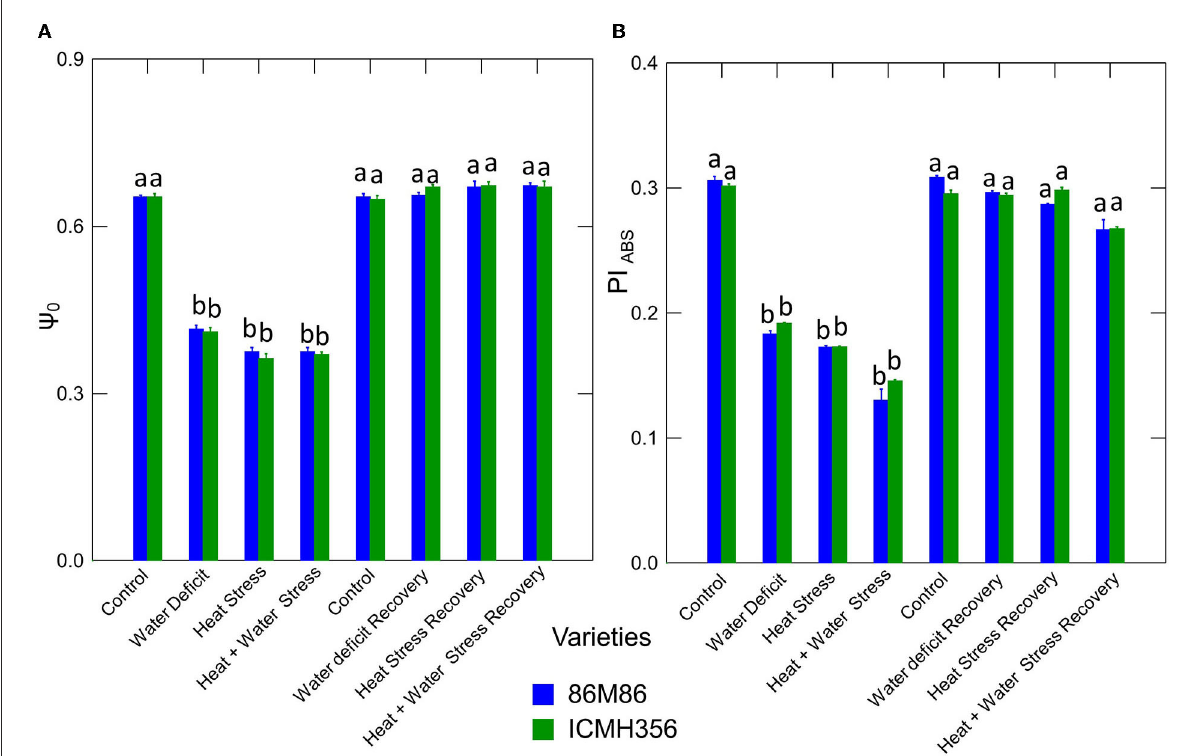
FIGURE8 Electron transport progression probability ψ 0 (A) and Performance Index on an absorption basis (PIABS) (B) in two varieties of pearl millet under water-deficit stress and heat stress in isolation and in combination and at recovery from stress (B) . Bars represent SE. Letters indicate significance at 0.05, and different letters indicate significant difference between